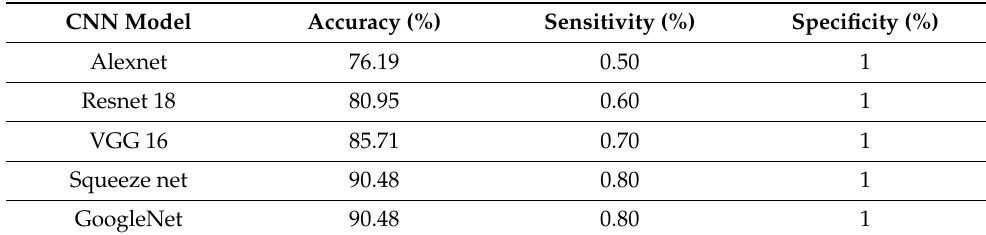
Table 2. Average accuracy performance for five tested CNN